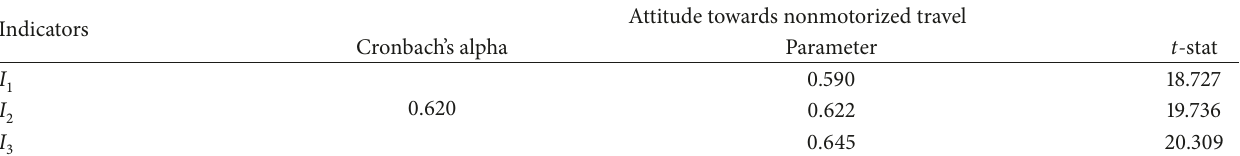
Table 4: Factor loading coefficients for the indicators of the latent